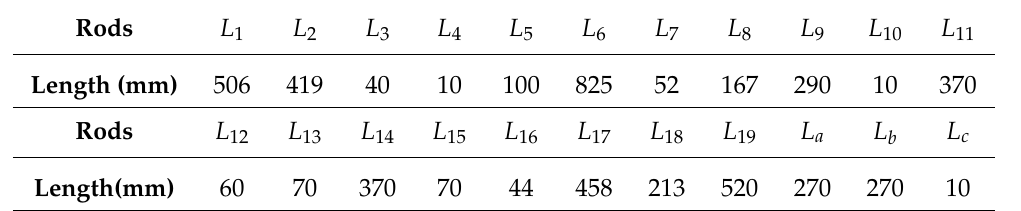
Table 5. Length of each